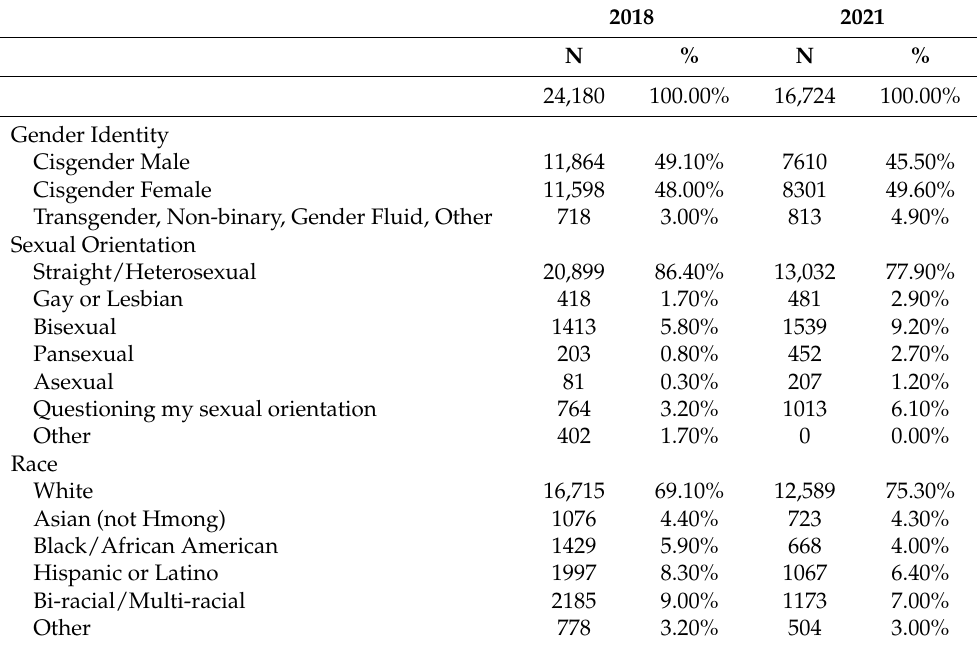
Table 1. Demographic characteristics of participants in the analytic